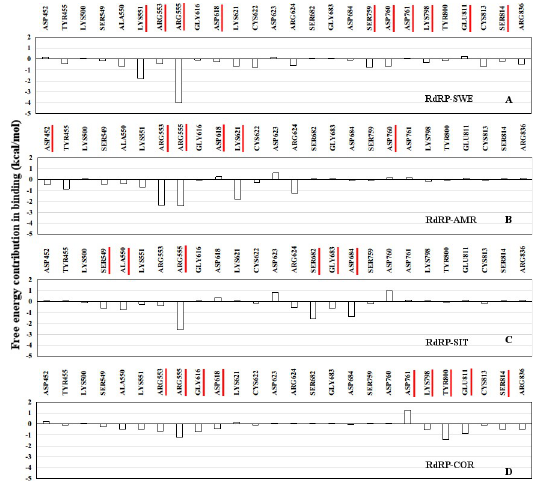
Fig 6. Contribution in binding by interacting residues. Residue-wise free energy contribution in binding between the ligands (A) SWE, (B) AMR, (C) SIT, and (D) COR and the RdRP protein.